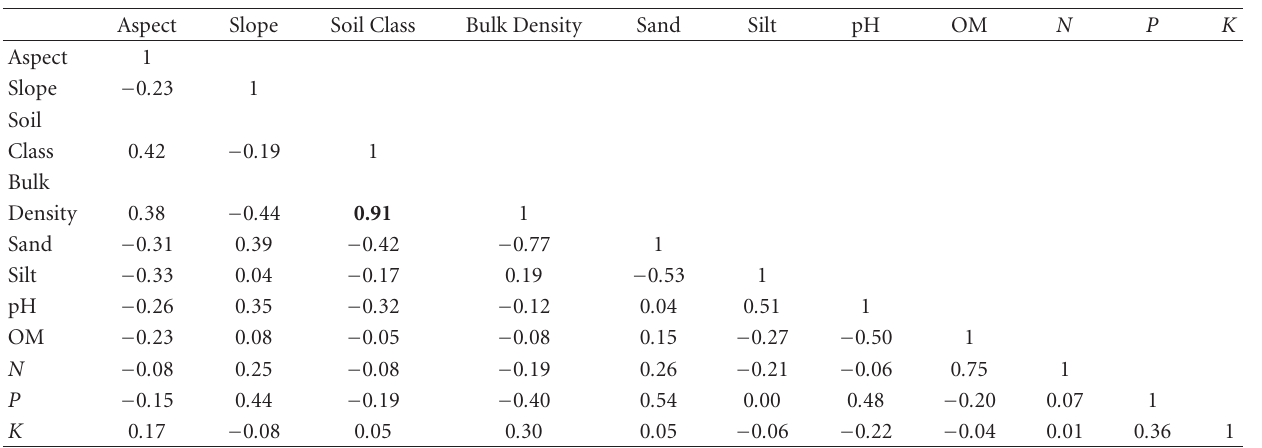
Table 7: Results from Spearman correlation analysis for Afzelia